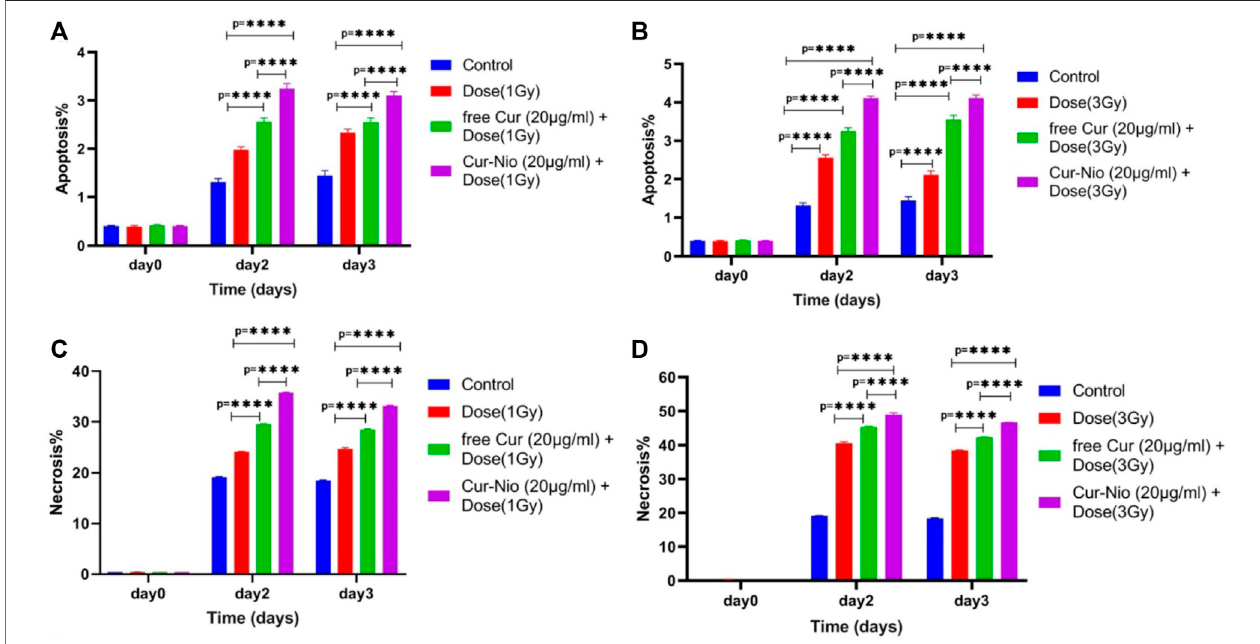
FIGURE 8 | Apoptosis rate of MCF7 cells treated with irradiation at doses of (A) 1 Gy and (B) 3 Gy with or without 20 μ g ml − 1 of the free curcumin and Cur-Nio (**** p < 0.0001). The necrosis rate of MCF7 cells treated with irradiation doses of (A) 1 Gy and (B) 3 Gy with or without 20 μ g ml − 1 of the free curcumin and Cur-Nio (**** p <